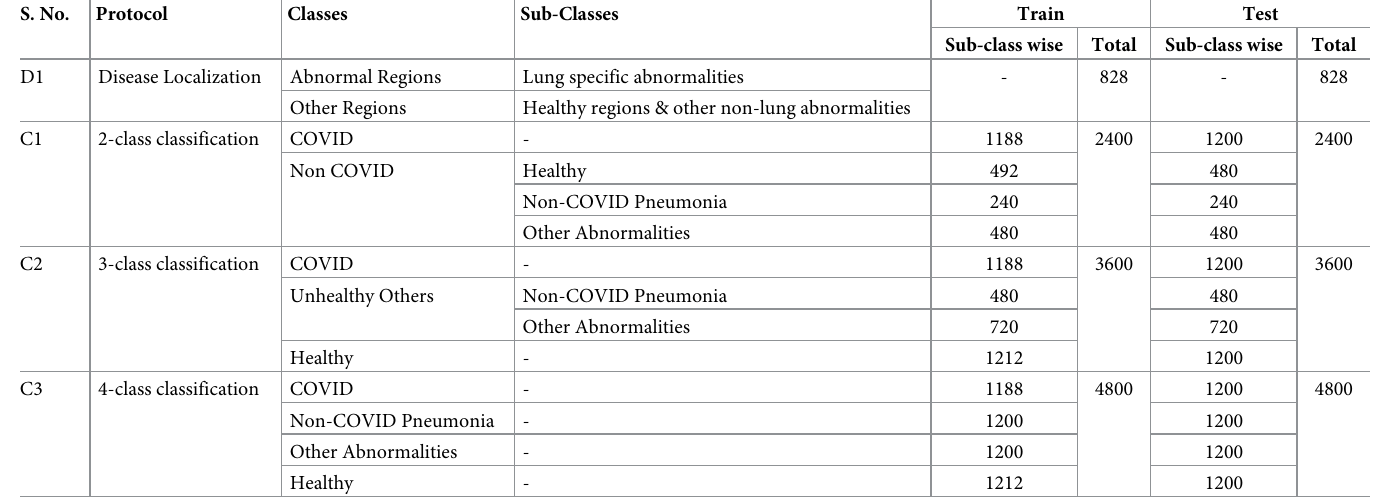
Table 2. Proposed experimental protocol for the train, validation, and test set of the proposed annotation dataset. 2-fold cross-validation is performed. The source images for COVID-19 X-rays are taken from the BIMCV-COVID19+ database, while the rest of the images are from the CheXpert database. The corresponding disease abnormality is provided in this